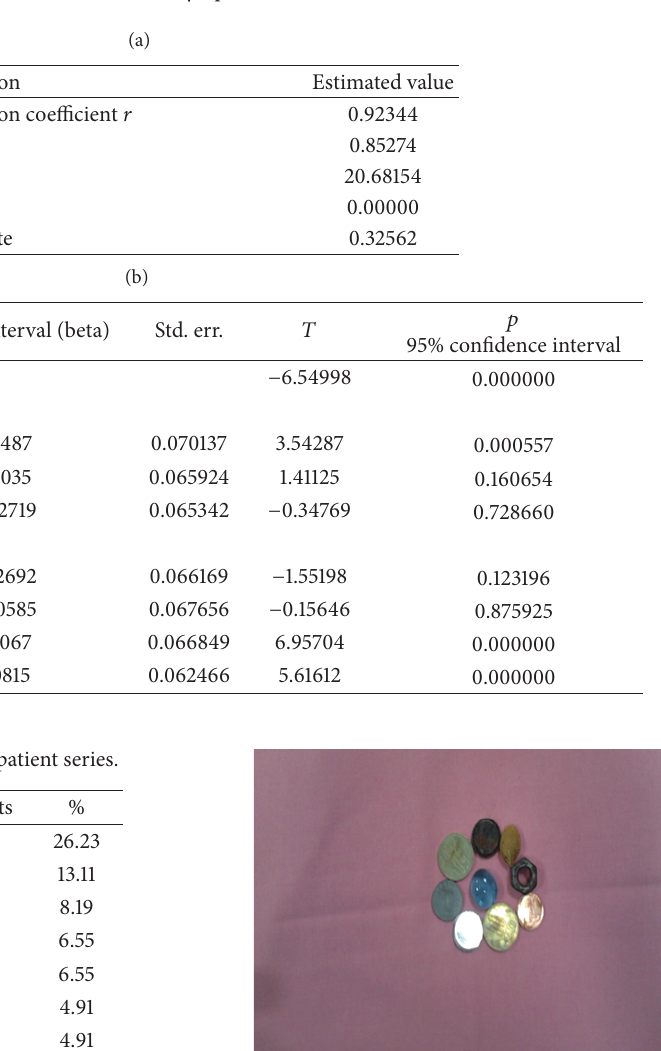
Table 2: Correlations between clinical symptoms and different factors.